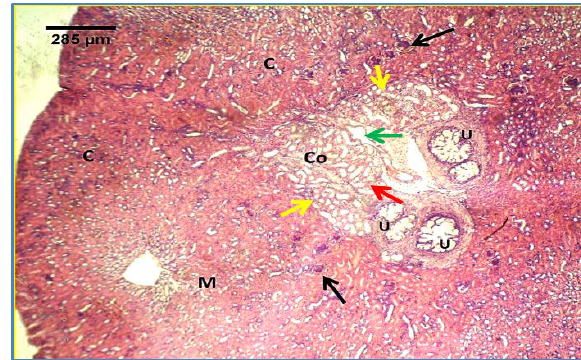
Figure, 3: section of kidney: shows cortex (C), medulla (M), branches of ureter (U), medullary cone (Co), renal corpuscles (Black arrows), zone of thin and thick segments of loop of Henle (Yellow arrows), collecting tubules (Red arrows), and wide vein (Green arrows). H and E– phloxine stain.